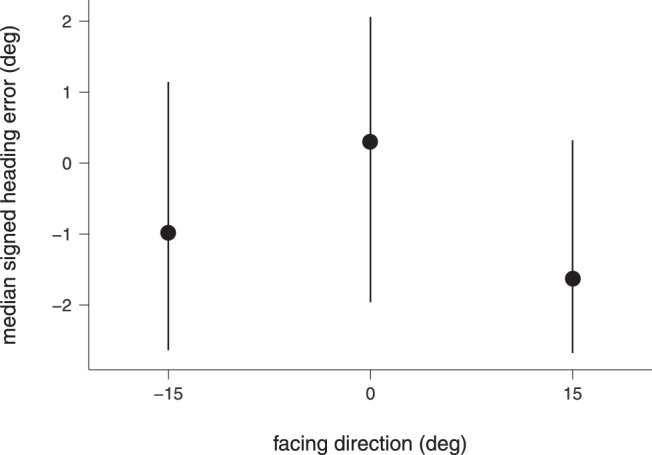
Median signed heading errors in the natural articulation-plus-translation condition for facing directions near the straight ahead (0°). Positive values indicate a heading bias to the right and negative values indicate a heading bias to the left. Error bars give the upper and lower interquartile ranges.